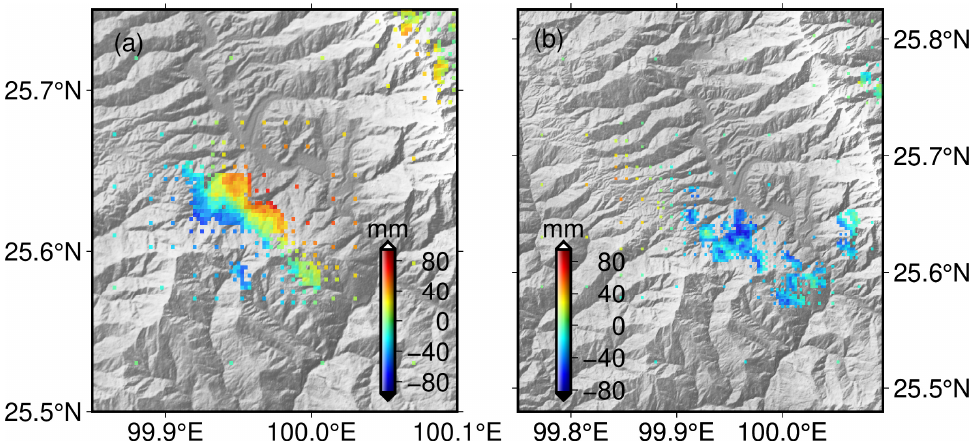
Figure 3. Quadtree sampling results of the coseismic deformation fi elds for ( a ) descending with 3003 observation points, and ( b ) ascending with 3390 observation points.